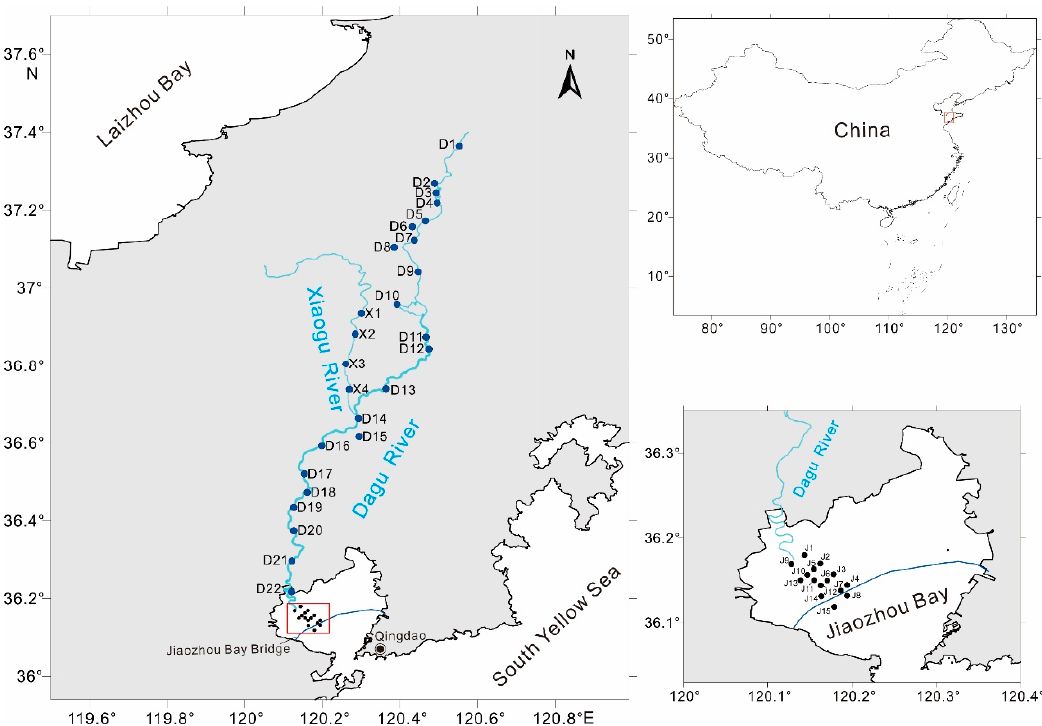
Figure 1. Sampling sites in the Dagu River Estuary, Southeast of Shandong Province.